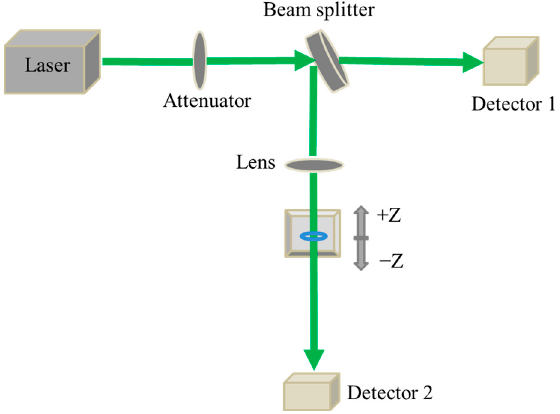
Figure 3. Schematic diagram of an open-aperture Z-scan.